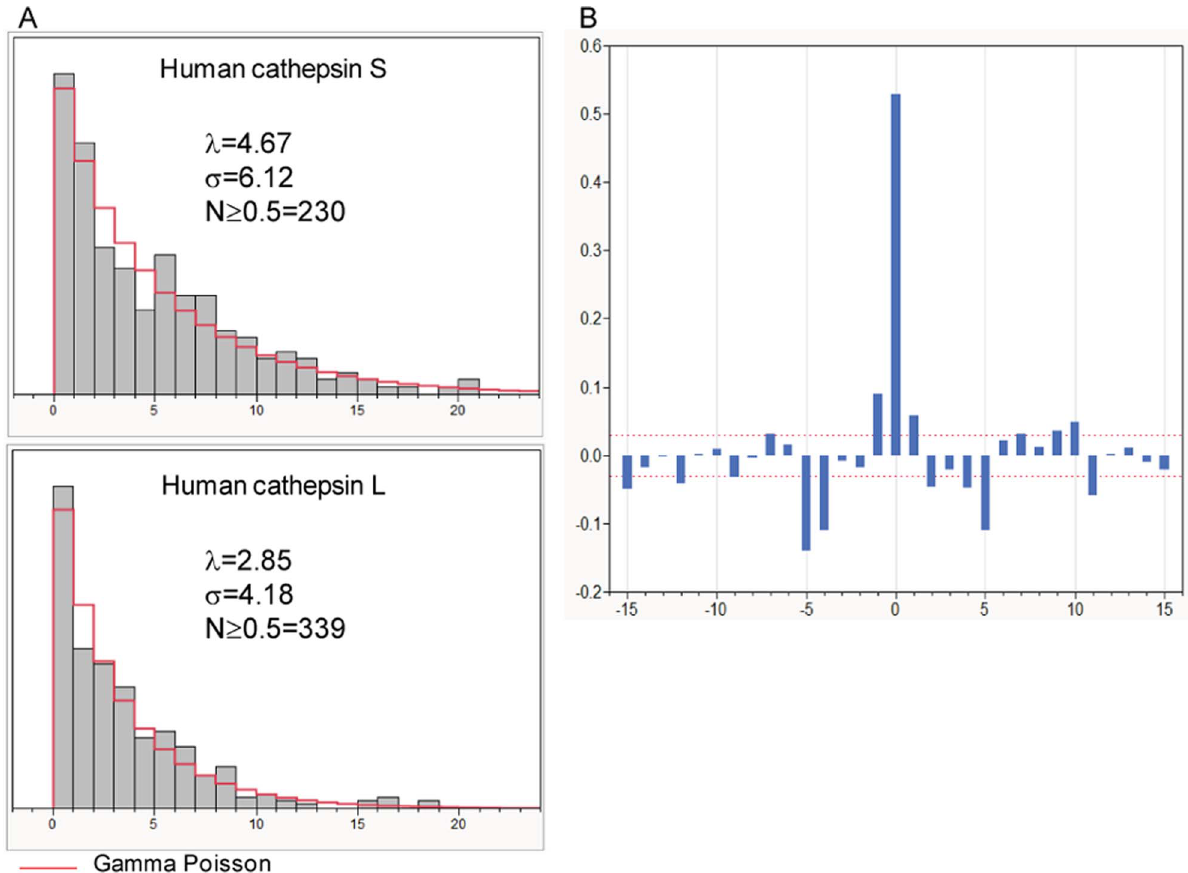
Figure 1. Predicted cleavage of tetanus toxin by human cathepsin L and S. A: Shows the distribution of the distance between successive cleavage probabilities of $ 0.5 for the two cathepsins. l =expected value (mean) and s =over dispersion (variance) of the fitted gamma Poisson distribution. B: Cross correlation of cleavage by cathepsin L and cathepsin S cleavage probabilities. A high correlation centered at zero indicates that the two cathepsins have a tendency to cut at the same site within the protein. This is flanked by high correlation of low probability of cleavage at 6 5 amino acids of the initial cleavage. The red dashed lines at 6 0.04 indicate the 95 th percentile confidence limits for non-significant correlation; values outside this band are significant p , 0.05.